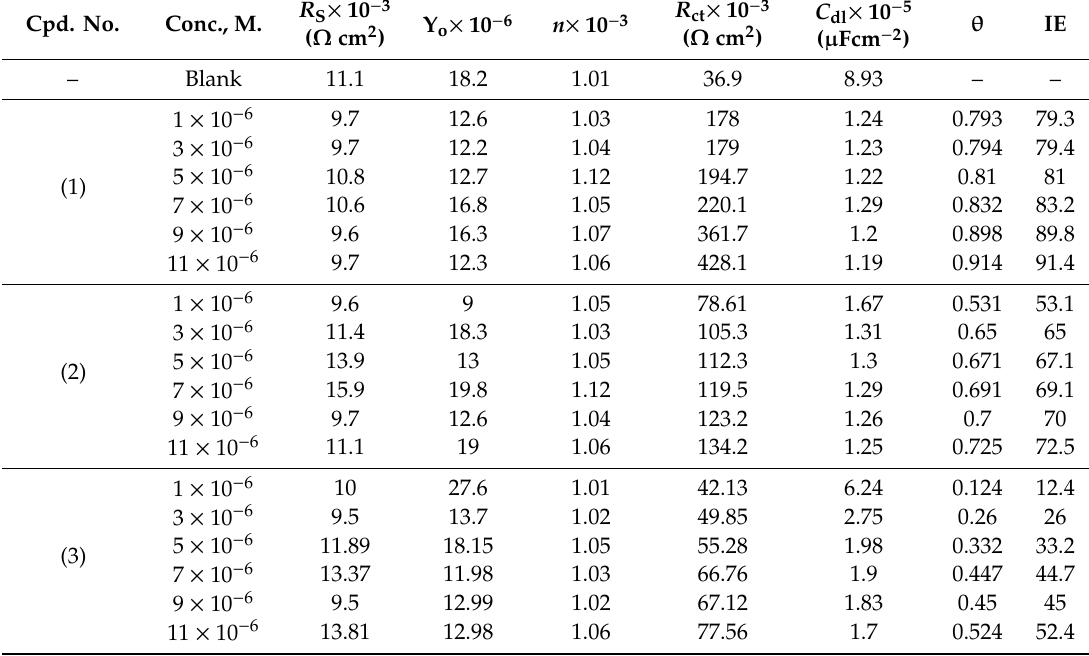
Table 3. Parameters given by EIS test for Q235 steel in corrosive environments attendance and lack of unlike dose of spiropyrazoles derivatives. Cpd. No.